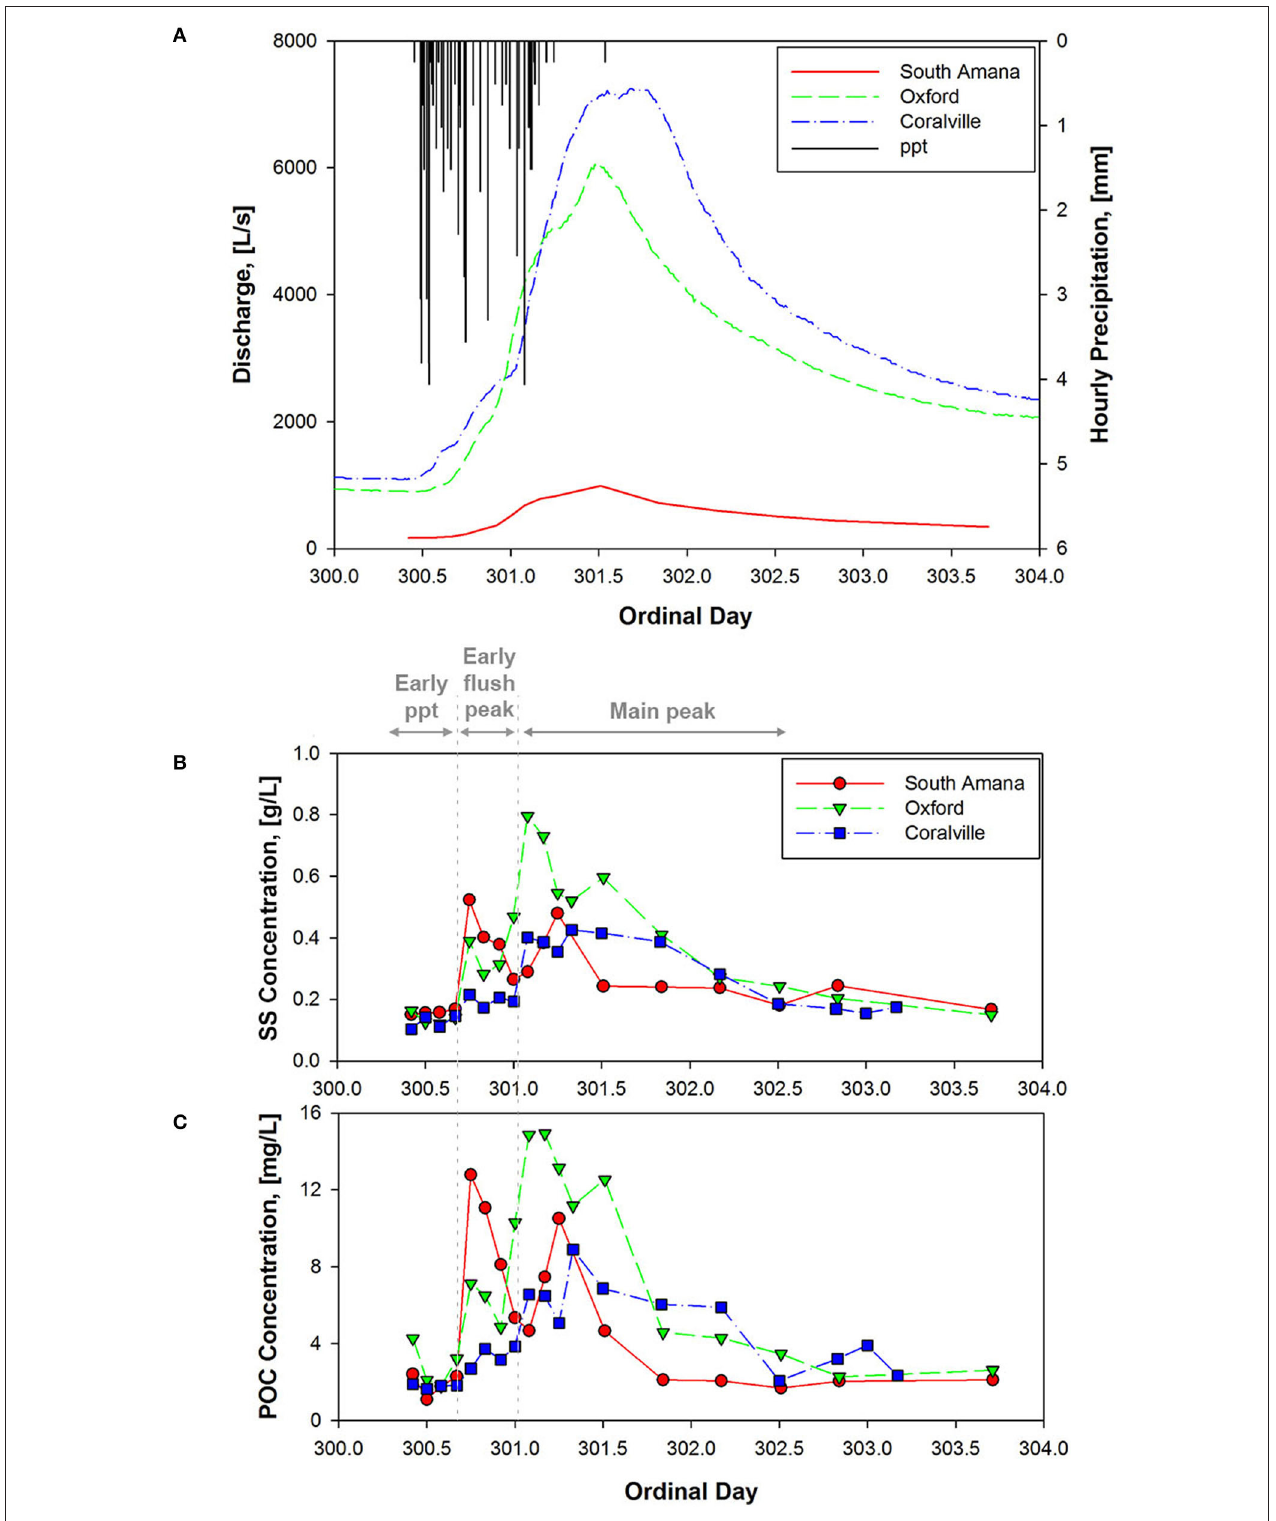
FIGURE 2 | (A) Hourly precipitation measured at near Iowa City and discharge at three sampling stations during 27–30 October 2015 storm; Temporal variation in the concentrations of (B) suspended sediment and (C) POC at three sampling stations. The early ppt phase refers to the period during the precipitation event before discharge rises rapidly. The early flush peak occurs on the rising limb of the hydrograph. The main peak correlates closely with discharge.